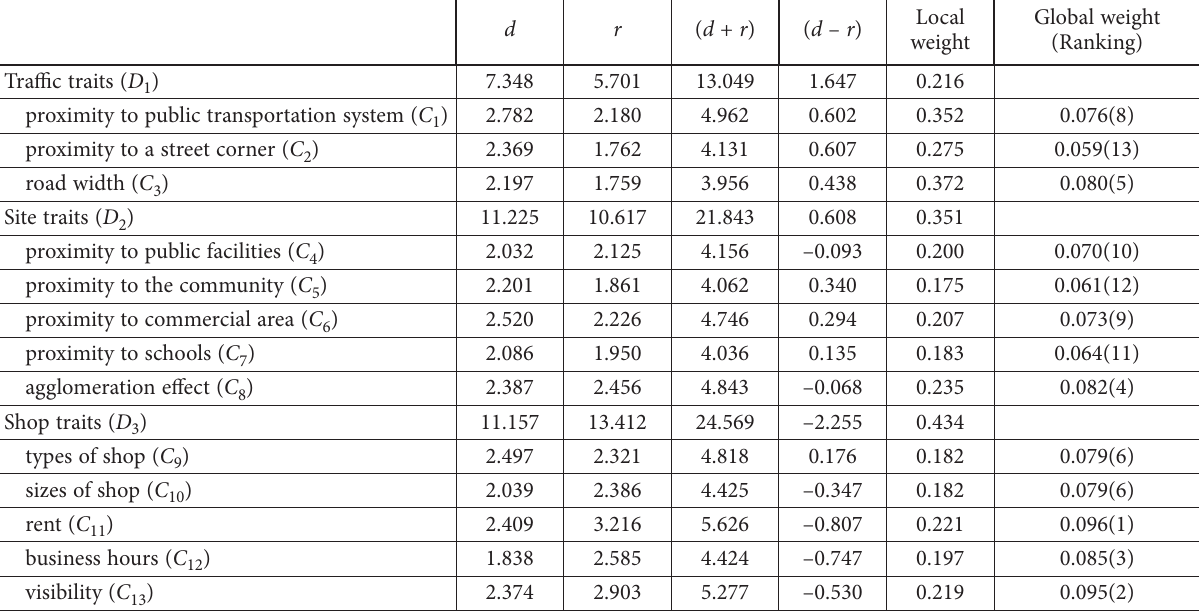
Table 9. The result of criteria calculated via DEMATEL and DANP d